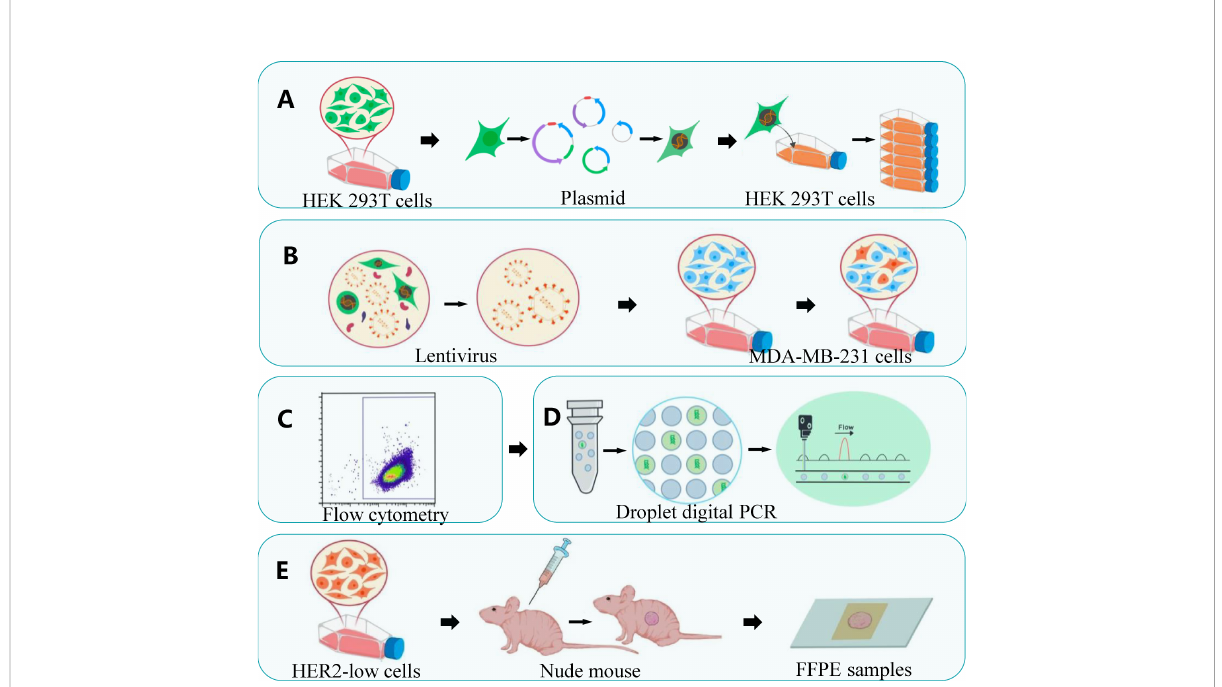
FIGURE 1 A schematic illustration of the generation of cell lines with HER2 expression in vitro and preparation of HER2-low FFPE reference material. (A) Recombinant lentivirus packaged and tittered in HEK 293T cells. (B) In vitro transduction in MDA-MB-231 cells (C) Detection of GFP expression by fl ow fl uorescence scan (D) Veri fi cation the monoclonal cells using droplet digital PCR. (E) FFPE samples derived from xenograft